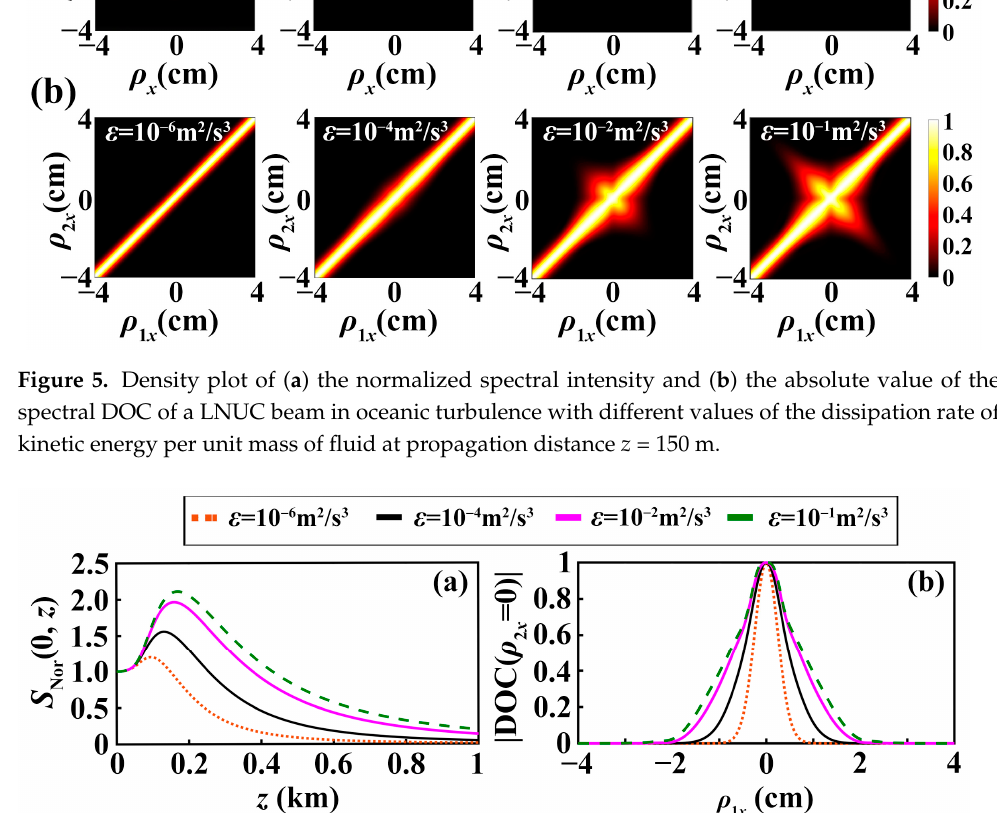
Figure 5. Density plot of ( a ) the normalized spectral intensity and ( b ) the absolute value of the spec ‐ tral DOC of a LNUC beam in oceanic turbulence with different values of the dissipation rate of kinetic energy per unit mass of fluid at propagation distance z = 150 m.